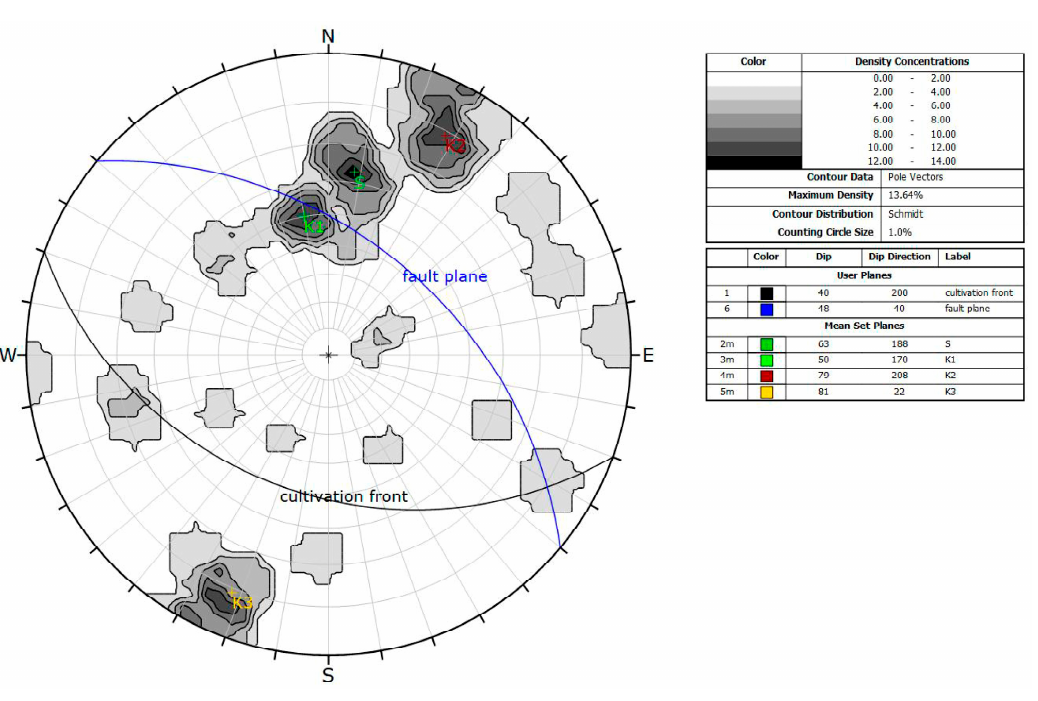
Figure 4. Stereoplot reporting the poles of the main discontinuity sets (S, K1, K2, K3) and the great circles of the front (Black) and fault plane (Blue).